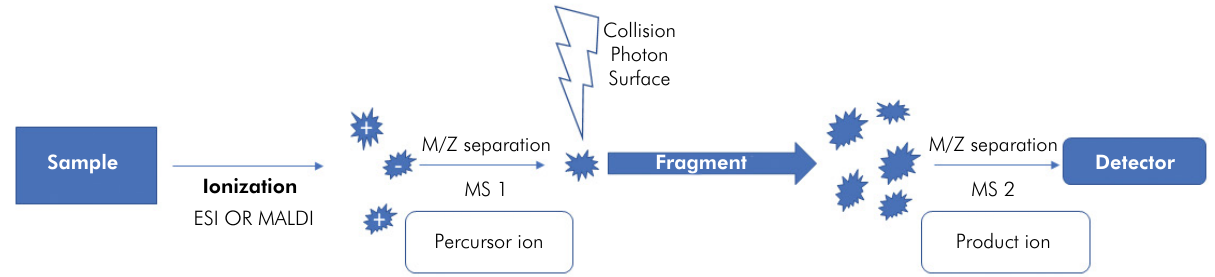
Figure 2. Tandem Mass Spectrometry